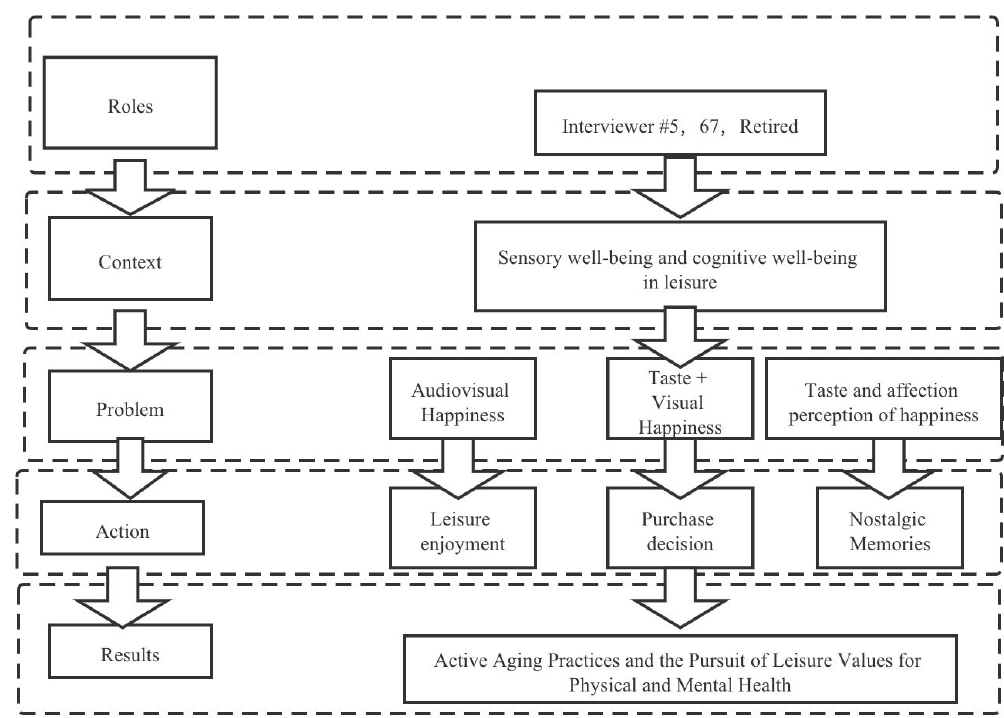
Figure 1. Example of respondent narrative analysis coding of R5.